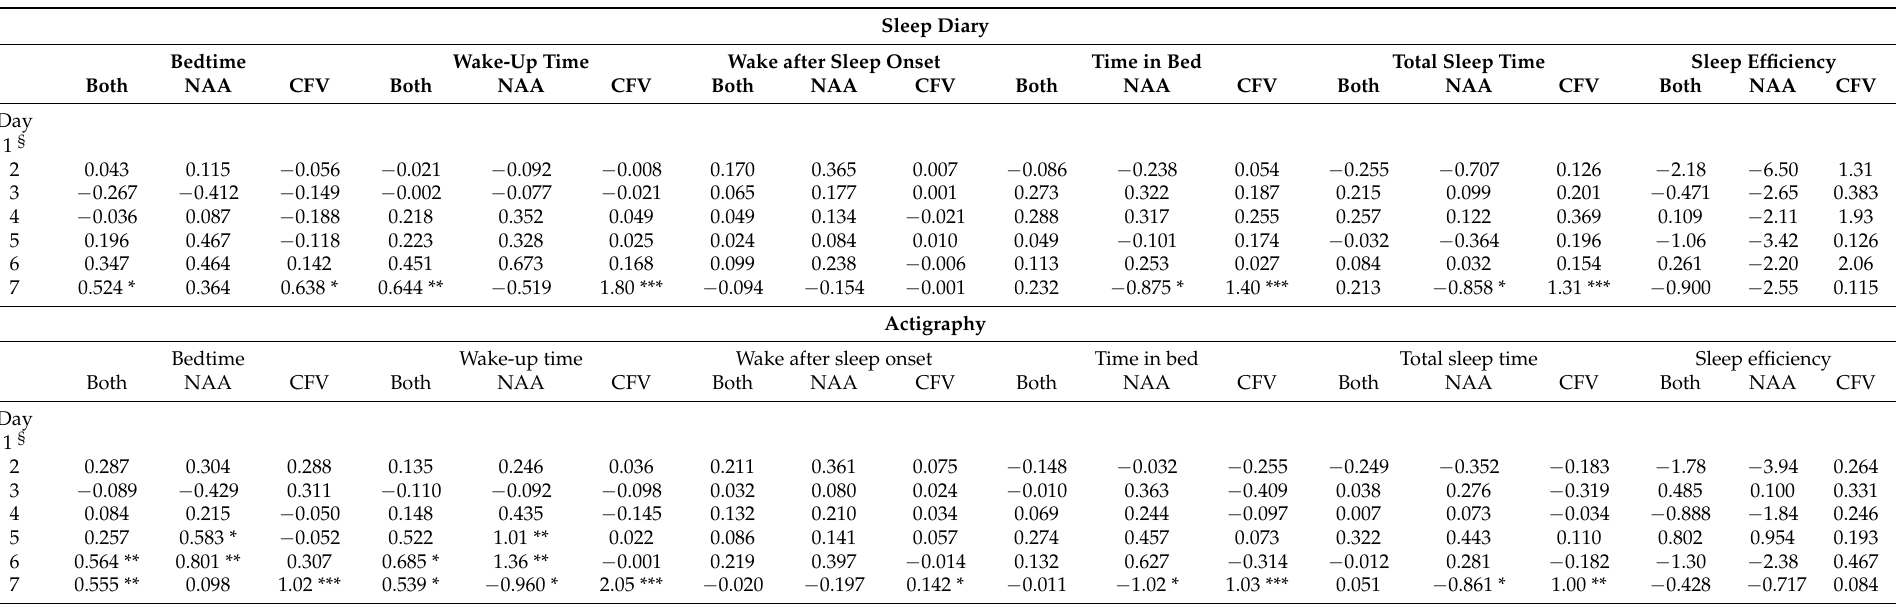
Table 2. Unstandardized beta coefficients for sleep variables in pilots from the Norwegian Air Ambulance (NAA; n = 25) and Christophorus Flugrettungverein (CFV; n = 22) during a workweek, derived from sleep diary and